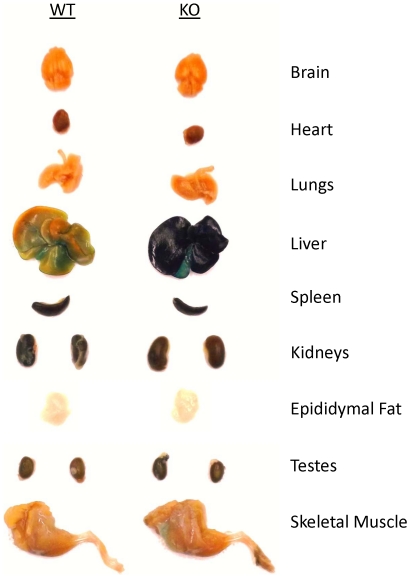
X-Gal staining of tissues from ApoF KO mice harboring a beta-galactosidase reporter gene.The targeted ApoF allele contains a beta-galactosidase reporter gene in place of ApoF. X-gal staining was performed on a wild type (WT) and an ApoF KO mouse (KO) to examine ApoF expression. The wild type mouse is included for an estimation of background staining for each tissue in the absence of beta-galactosidase.